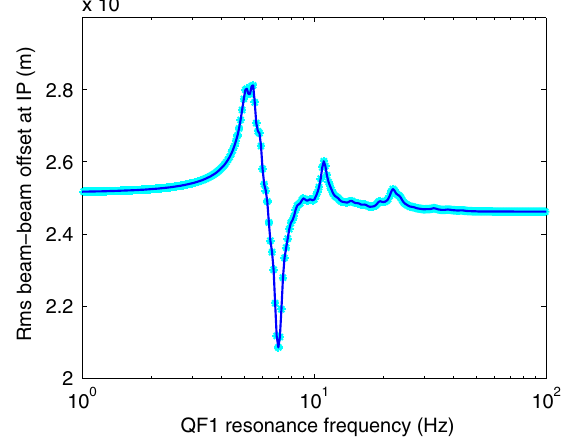
FIG. 15. Beam-beam offset integrated down to 5 Hz as a function of the resonance frequency of the